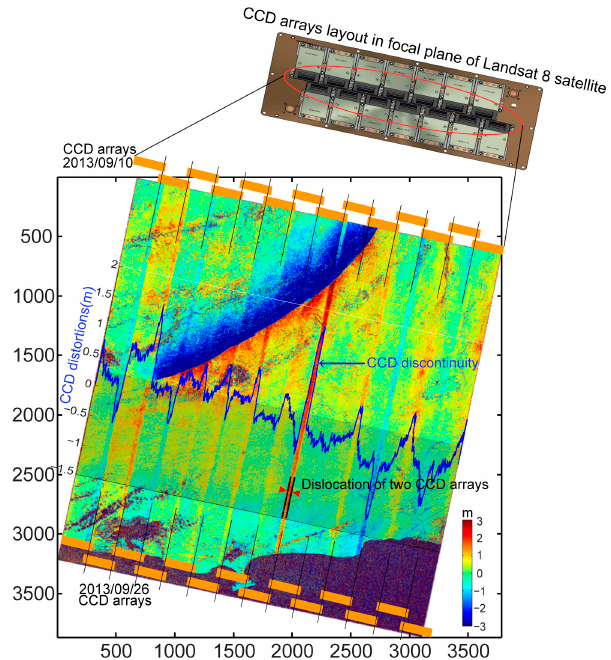
Figure 5. Relevance of the SA (stripe artifacts) and the CCD (Charge Coupled Device) arrays’ relative locations superimposed on the E/W component of the crustal deformation field. The yellow rectangles represent CCD arrays’ locations acquired on the images from: 10 September 2013 ( top ); and 26 September 2013 ( bottom ). The dislocation between the two CCD arrays presents inconsistency in scene center (spatial baseline), which is the main reason causing the SA. The misalignment between CCD sub-arrays in a single CCD chip is identified as the essential reason. Blue profile line represents the average along flight direction of gray block area with a magnitude range of − 1.5 m–2 m ( − 0.1–0.13 pixels).